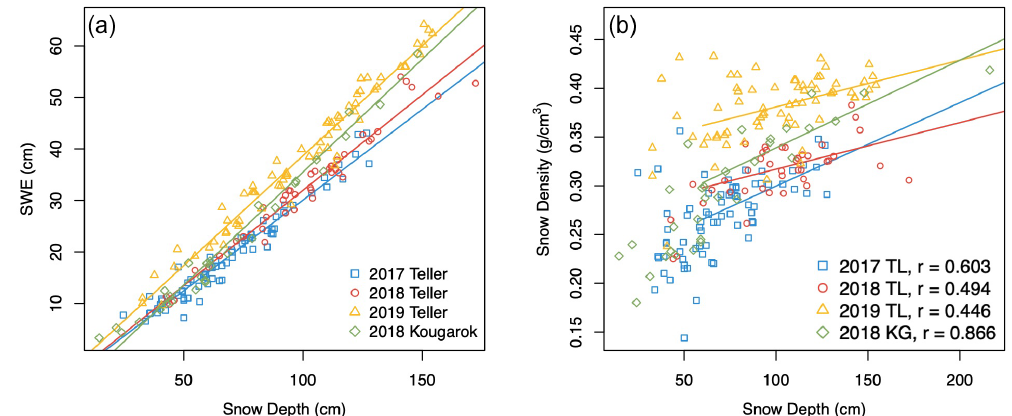
Figure 3. Scatterplots of (a) snow depth vs. SWE and (b) snow depth vs. snow density. The linear regressions in panel (b) are for snow depth > 60cm.